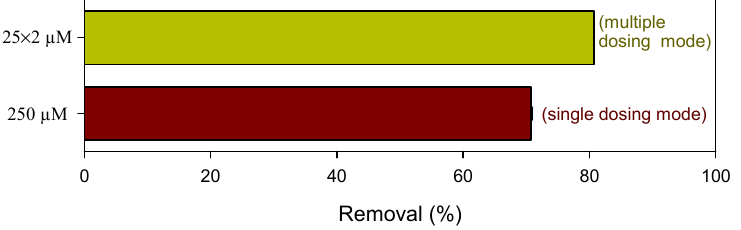
Figure 3. Influence of HSO 3 − applied at different modes on the oxidation of CBZ by Mn(III) at pH 7.0. Conditions: [CBZ] 0 = 5 µM, [Mn(III)] 0 = 50 µM, [PP] 0 = 2.5 mM. Note: multiple dosing mode represents that 125 µM of HSO 3 − was dosed at the reaction time of 20 and 40 s, respectively.